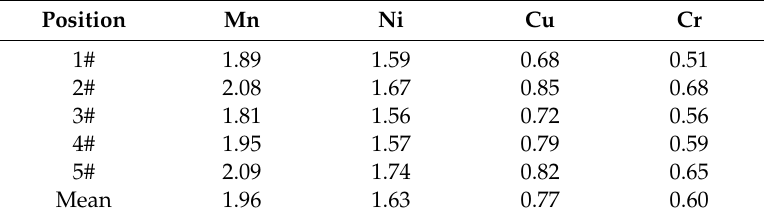
Figure 4. Examined schematic image of fresh martensite after intercritical annealing ( a ); examined results of alloying elements distribution by FEG-SEM ( b ). Table 1. Concentration of alloying elements in M for specimen 3#.